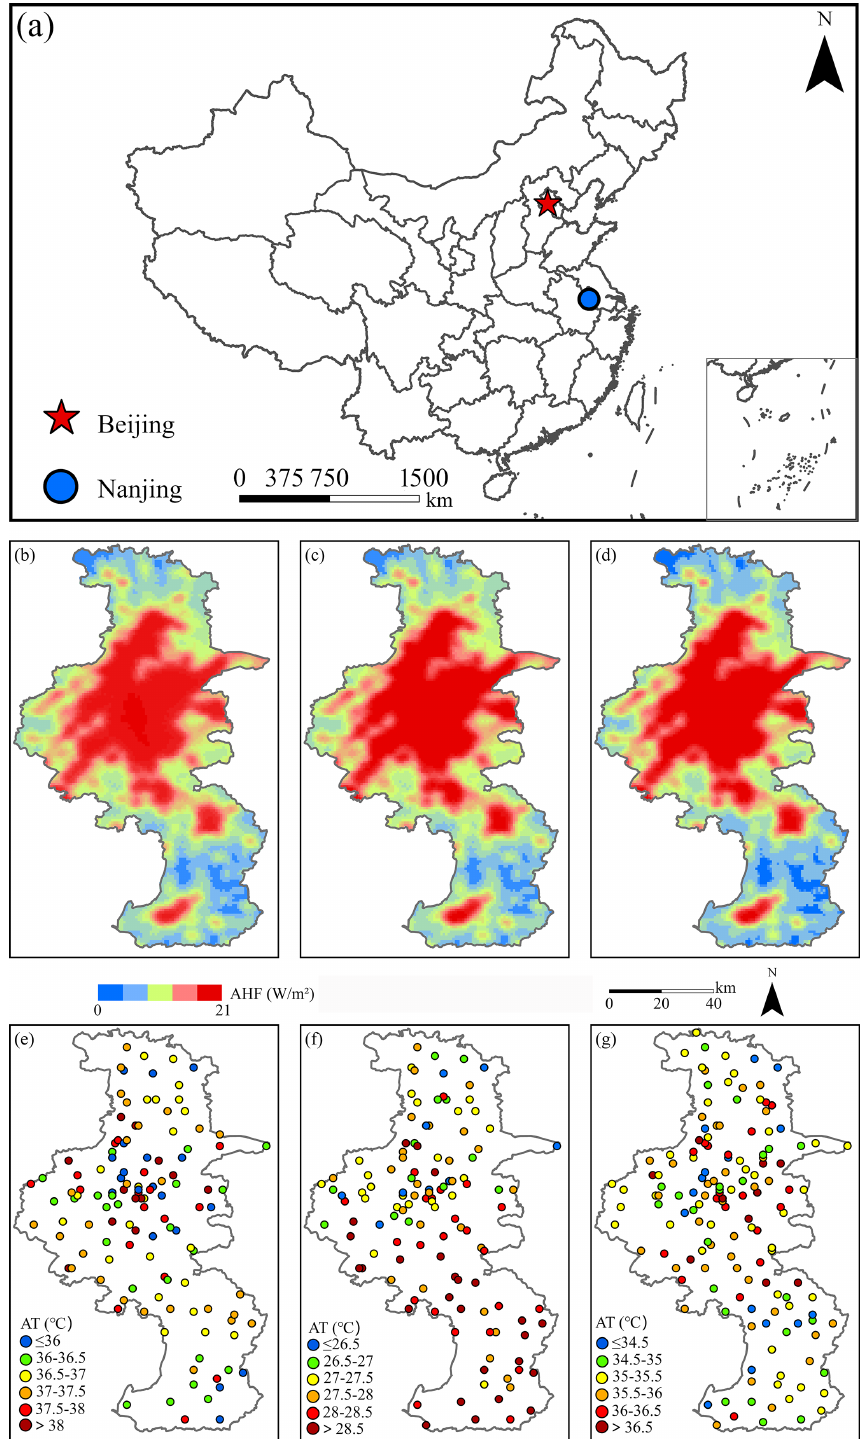
Figure 1. Anthropogenic heat flux of Nanjing city and locations of high-density automatic meteorological stations in Nanjing with recorded air temperature: (a) location map of Nanjing in China; (b, e) 11:00LT on 11 August 2013; (c, f) 11:00LT on 2 September 2015; (d, g) 11:00LT on 21 July